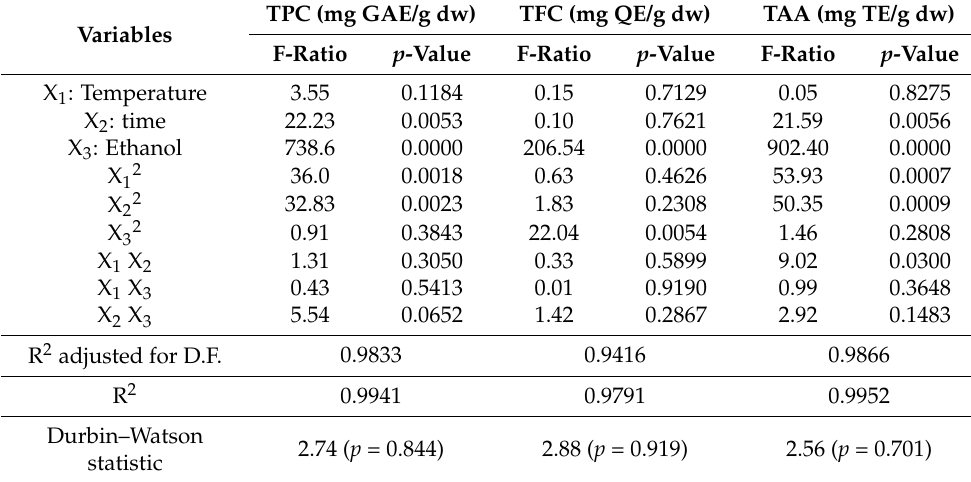
Table 2. F-test ratio, coefficient of regression R 2 , Durbin–Watson statistic and p -values of the predicted model for TPC, TFC and TAA from cornelian cherry conventional